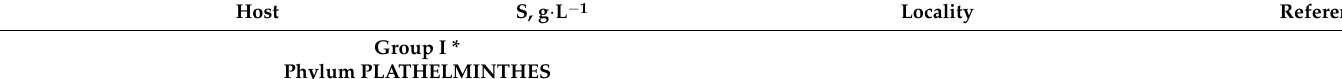
Table 1. Parasitic animal species found in hypersaline waters around the